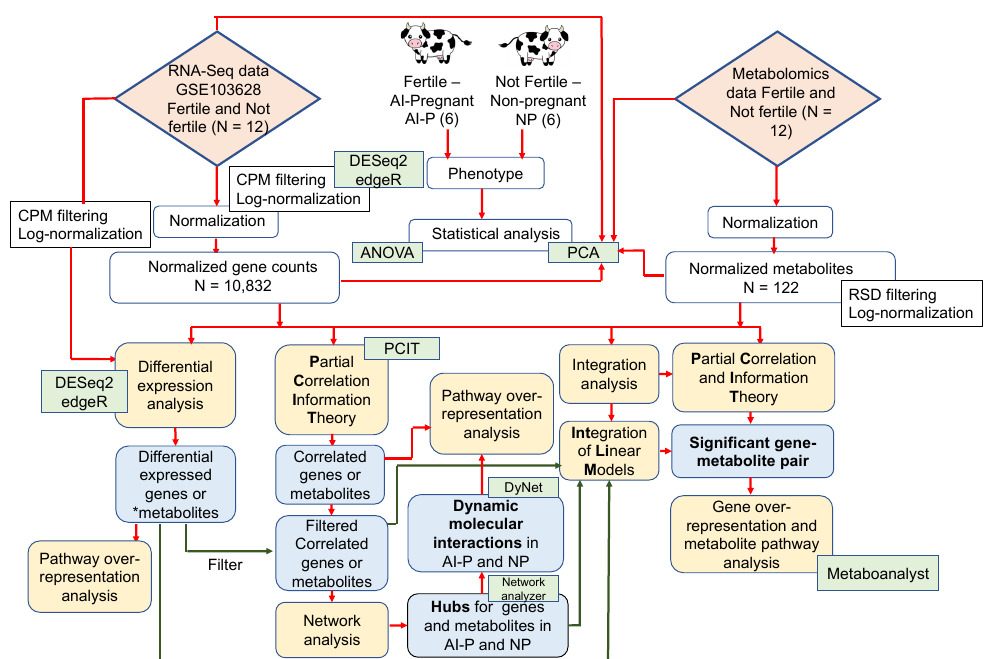
Figure 1. Schematic representation of the study design and analysis steps. The yellow boxes represent the analysis steps; the green boxes represent the software/packages used; and the blue boxes represent the output obtained. The red connectors point to the main analysis steps, while the green connectors are the analysis after filtering. * Differentially expressed metabolites retrieved from Phillips et al. [25]. After quality control (see Section 4.2), we maintained 10,832 genes out of 24,616 from 12 heifers for differential expression analysis. Based on a combined approach using edgeR and DESeq2 (see section 4), we identified 38 differentially expressed genes (DEGs, p -value ≤ 0.05 and absolute (log2 fold change ≥ 0.5)) (Figure 2, Supplementary Table S1). Among the DEGs, 29 genes were upregulated and 9 were downregulated in the NP group. Up- regulated genes (top five in the list) included TFF2 , TAC3 , CNKSR3 , ALAS2 and MYH10 ,